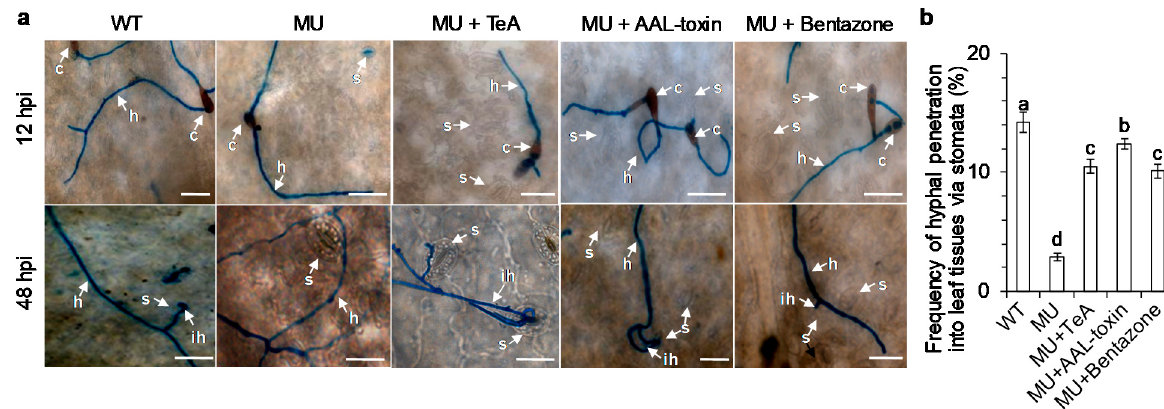
Figure 9. Effect of endogenous TeA, AAL-toxin, and bentazone on conidia germination, hyphal growth, and penetration on A. adenophora inoculated by A. alternata mutant ∆ HP001 . A. adenophora leaves were inoculated by A. alternata wild-type (WT) conidia (8 × 10 5 conidia mL − 1 ), mutant ∆ HP001 (MU) conidia (8 × 10 5 conidia mL − 1 ), MU conidia (8 × 10 5 conidia mL − 1 ) with 20 µ g mL − 1 TeA (10 µ L) (MU + TeA) or 20 µ g mL − 1 AAL-toxin (10 µ L) (MU + AAL-toxin) or 200 µ g mL − 1 bentazone (10 µ L) (MU + bentazone). ( a ) Conidia germination and development and hyphal penetration at 12 and 48 hpi. Here, s: Stomata; c: Conidium; h: Hypha; ih: Invasive hypha. Scale bars = 20 µ m. ( b ) The frequency of hyphal penetration into leaf tissues via the stomata. The tissue was stained with lactophenol-trypan blue to visualize hyphae. Hypha from at least 300 stomata were counted. Data shown are mean values ± SD of three independent biological replicates. Different small letters above the error bar mean a significant difference at 0.05 level.